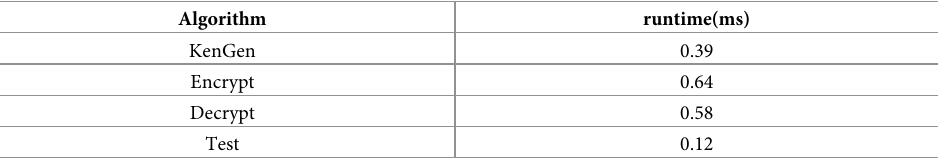
Table 8. Computational efficiency of 512bit.